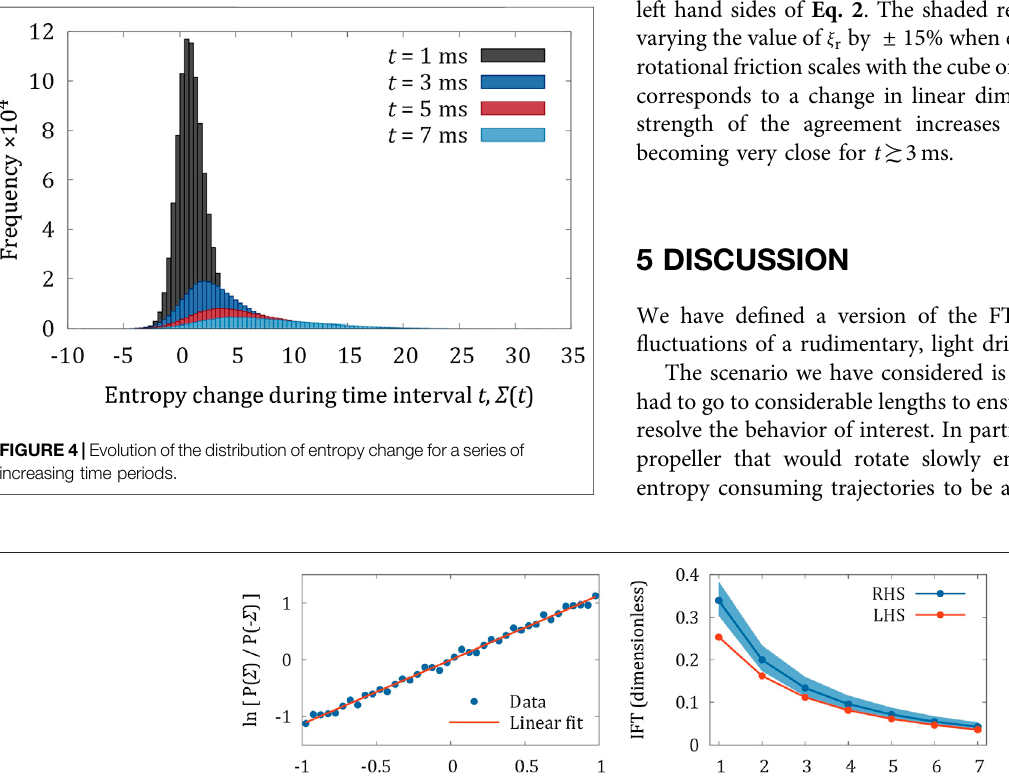
Frontiers in Physics |